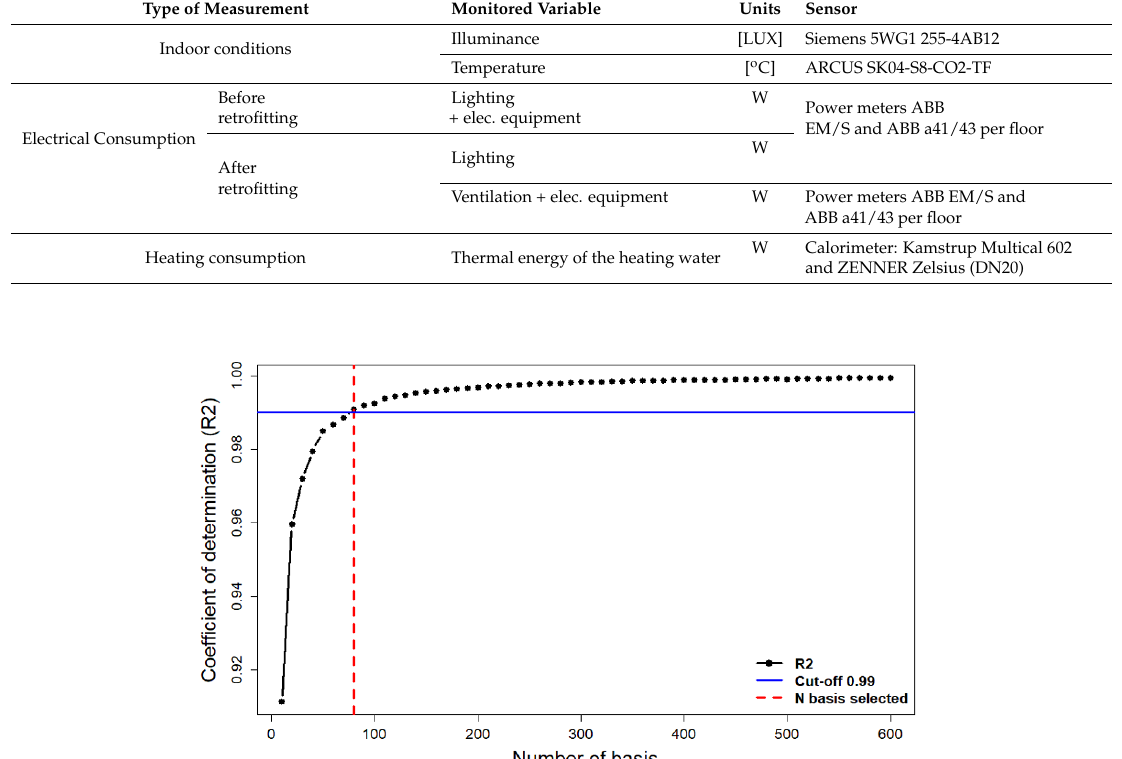
Figure 3. Example of the process of selecting the optimum number of basis for smoothing the original sample. The red line represents the minimum number of basis where the R 2 is higher than